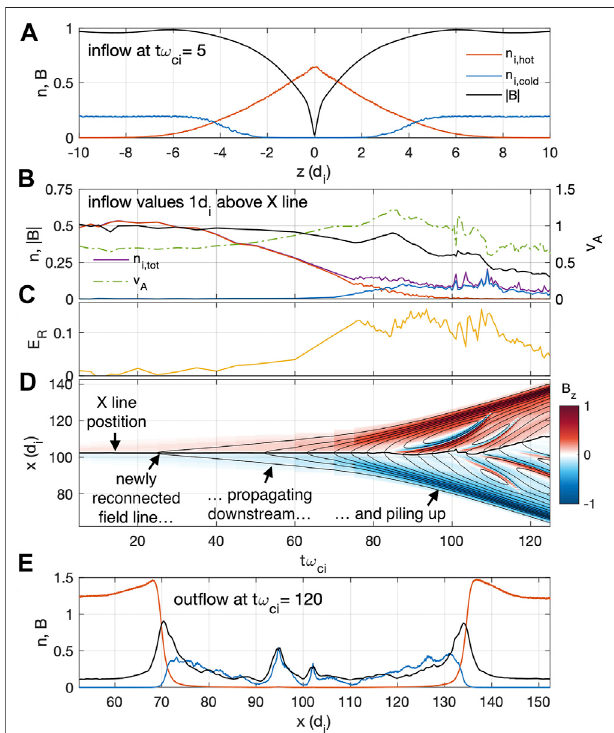
FIGURE 1 | (A) Magnetic fi eld | B | and densities n i , hot , and n i , cold in the in fl owalongaverticalcutthroughtheXlineat t ω ci (cid:1) 5. (B) | B |, n i , hot , n i , cold , n tot , and v A inthein fl ow1 d i abovetheXline. (C) Reconnectionrate,herede fi nedas theout-of-planeelectric fi eld E y attheXline. (D) Magnetic fi eld B z around the equatorial plane as function of time and x . The thicker black line shows the location of the X line, while the thinner black lines show equipotential contours of A y . Newly reconnected fi eld lines appear at the X line and propagate outwards. (E) Magnetic fi eld | B | and densities n i , hot , and n i , cold in the out fl ow along a horizontal cut through the X line at t ω ci (cid:1) 120. Note that the colors of the lines are consistent throughout the fi gure, and wetherefore only de fi ne the legend the fi rst time a quantity